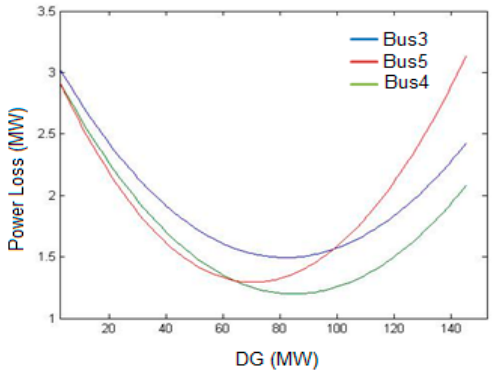
Figure 9. Bus losses with different wind farm locations.